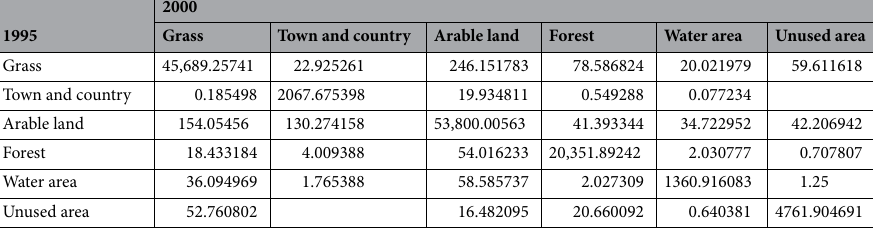
Table 4. Transfer matrix of land use types in the study area from 1995 to 2000 (km 2 ).